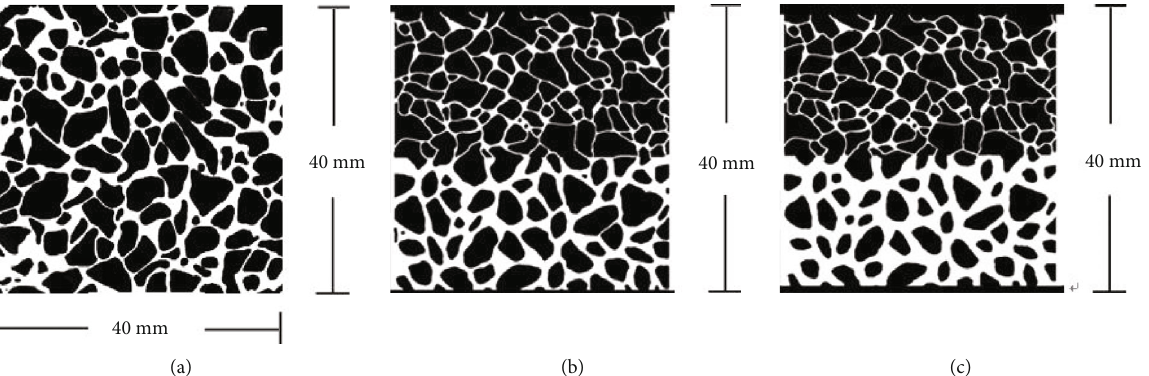
Figure 1: Schematic diagram of planar heterogeneous photolithographic glass model: (a) the permeability ratio of 1; (b) the permeability ratio of 6; (c) the permeability ratio of